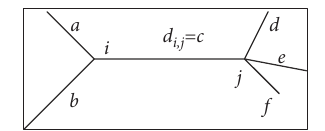
Figure 4: Path connected with two